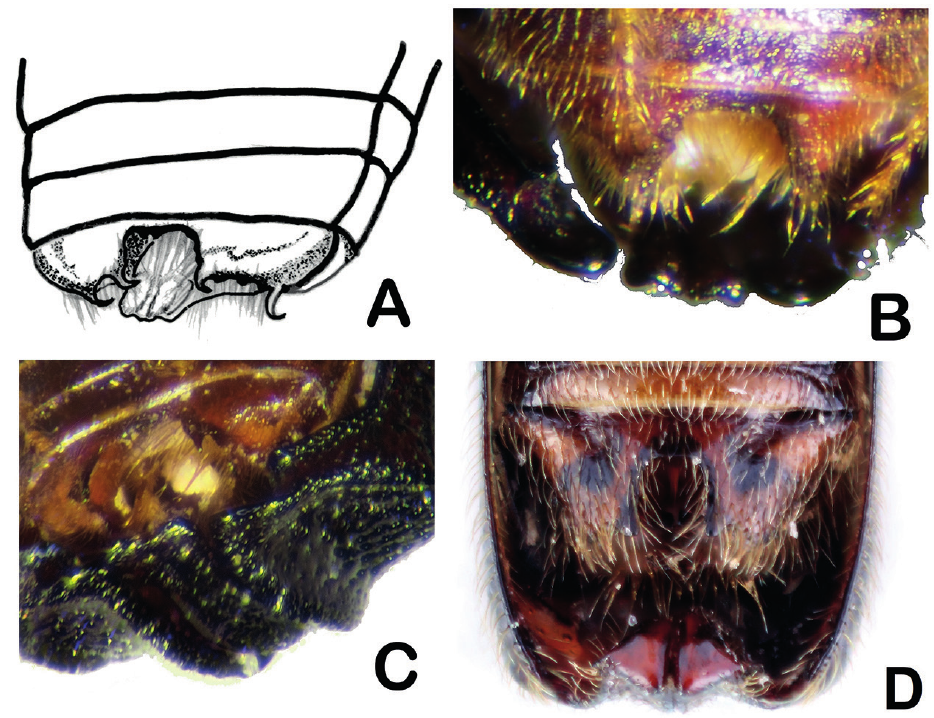
Fig. 4. Apical posterior of female of Infrantenna gen. nov. and Psicula Lesne 1941. A–C . Infrantenna fissilis gen. et sp. nov., allotype (NHMUK014433956). A . 2 nd to 5 th visible abdominal ventrites and apical part of last tergite with two very dense, short hairy oval pads on apex. B . Ventral view of last two ventrites. C . Apical-lateral view of last ventrite and declivity. D . Psicula heterogama Lesne 1941, ventral view of last two visible abdominal